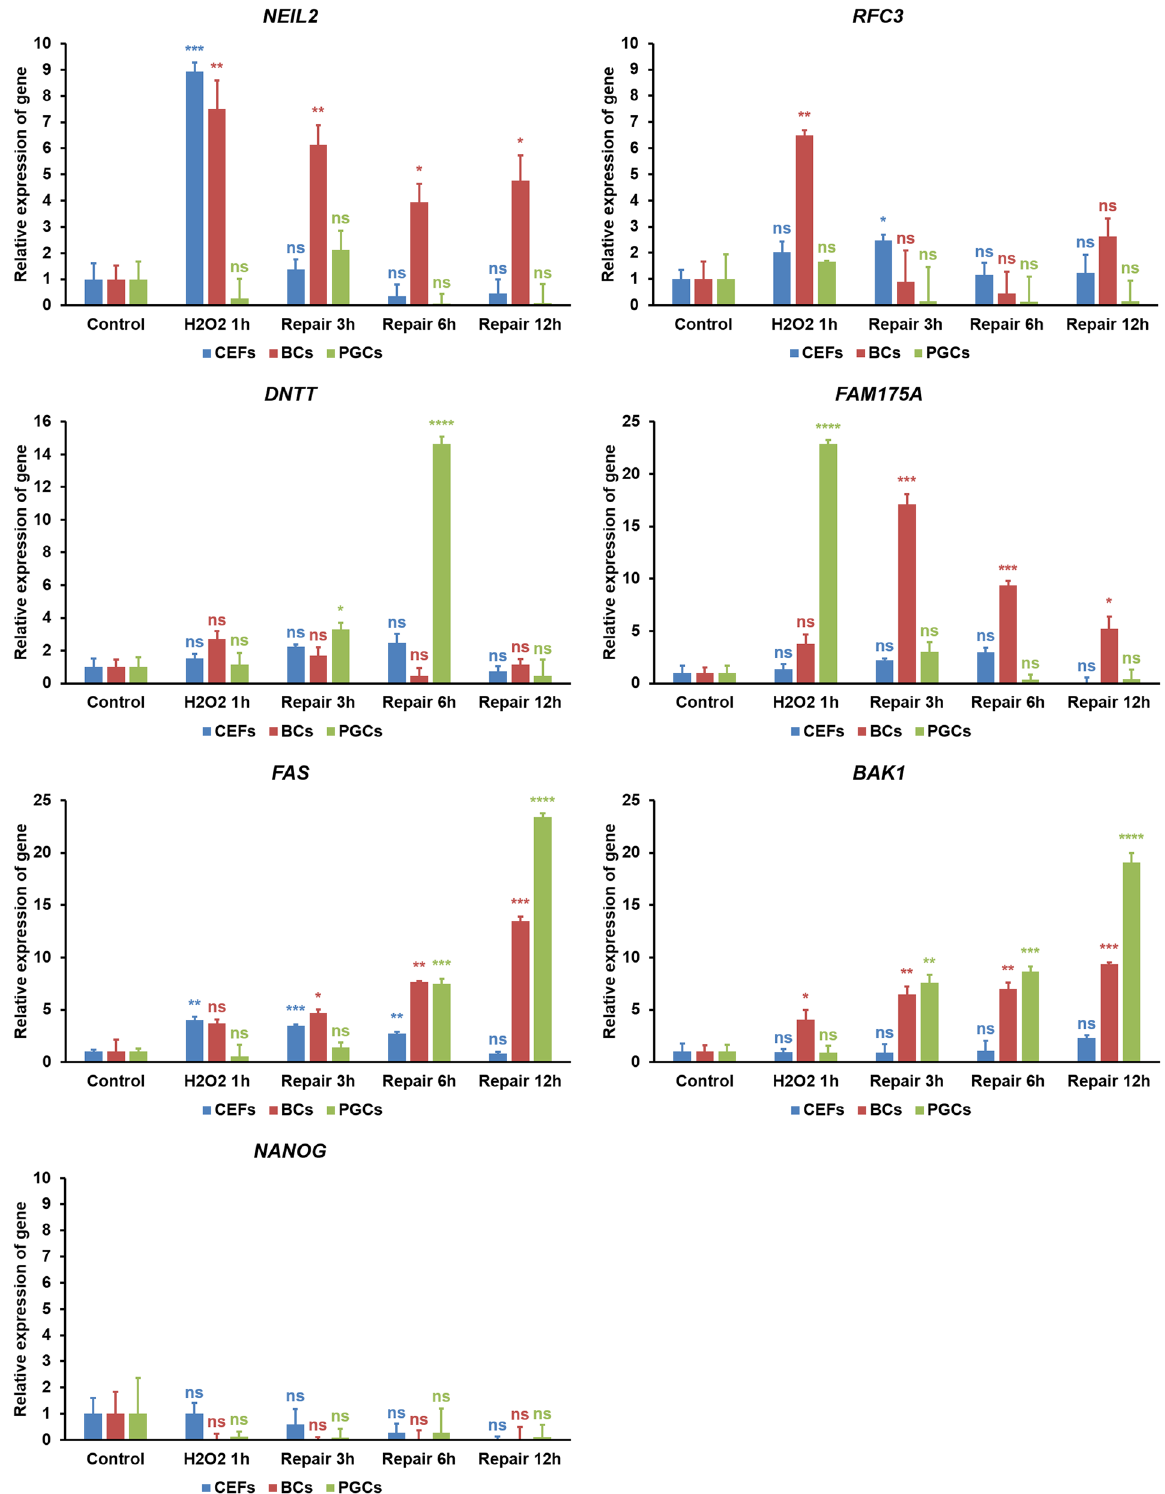
Figure 8. RT-qPCR analysis in CEFs, EGK.X blastoderm cells (BCs), and PGCs treated with H 2 O 2 . The cultured CEFs, EGK.X blastoderm cells, and PGCs were treated with 1 mM H 2 O 2 for 1 h (H 2 O 2 1 h) in one group. In three other groups, the cells were treated with 1 mM H 2 O 2 for 1 h, and then incubated in fresh media without H 2 O 2 for 3 h (repair 3 h), 6 h (repair 6 h) and 12 h (repair 12 h). After treatment, cDNA of the cells was prepared and amplified with specific qPCR primers of the candidate genes from the BER pathway ( NEIL2 ), NER/MMR pathway ( RFC3 ), NHEJ pathway ( DNTT ), HR pathway ( FAM175A ), apoptosis pathway ( FAS and BAK1 ), and pluripotency regulating pathway ( NANOG ). The relative expression of genes was normalized with the chicken GAPDH and respective control sample, and analyzed by the 2 −ΔΔCt method. Significant differences between the respective control and treated samples were determined by Student’s t test. Statistical significance was ranked as * P < 0.05, ** P < 0.01, *** P < 0.001, or **** P < 0.0001. ns ,